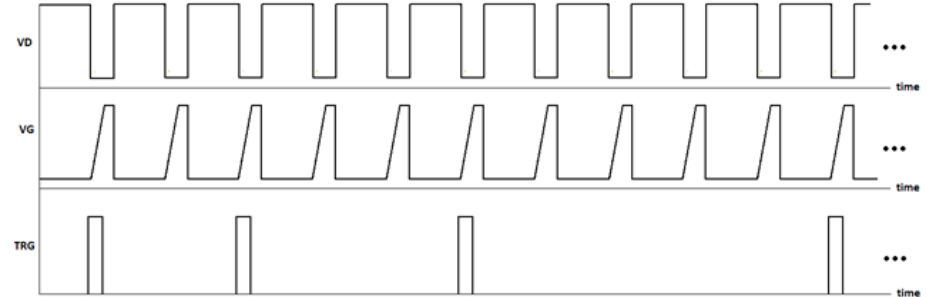
Figure 3. Typical measurement sequence: The Device Under Test (DUT) is repeatedly switched ON and OFF at each cycle, but the trigger signal (TRG) is generated only for some predefined periods logarithmically spaced in time. This avoids the DSO’s memory saturation, preserving time accuracy.